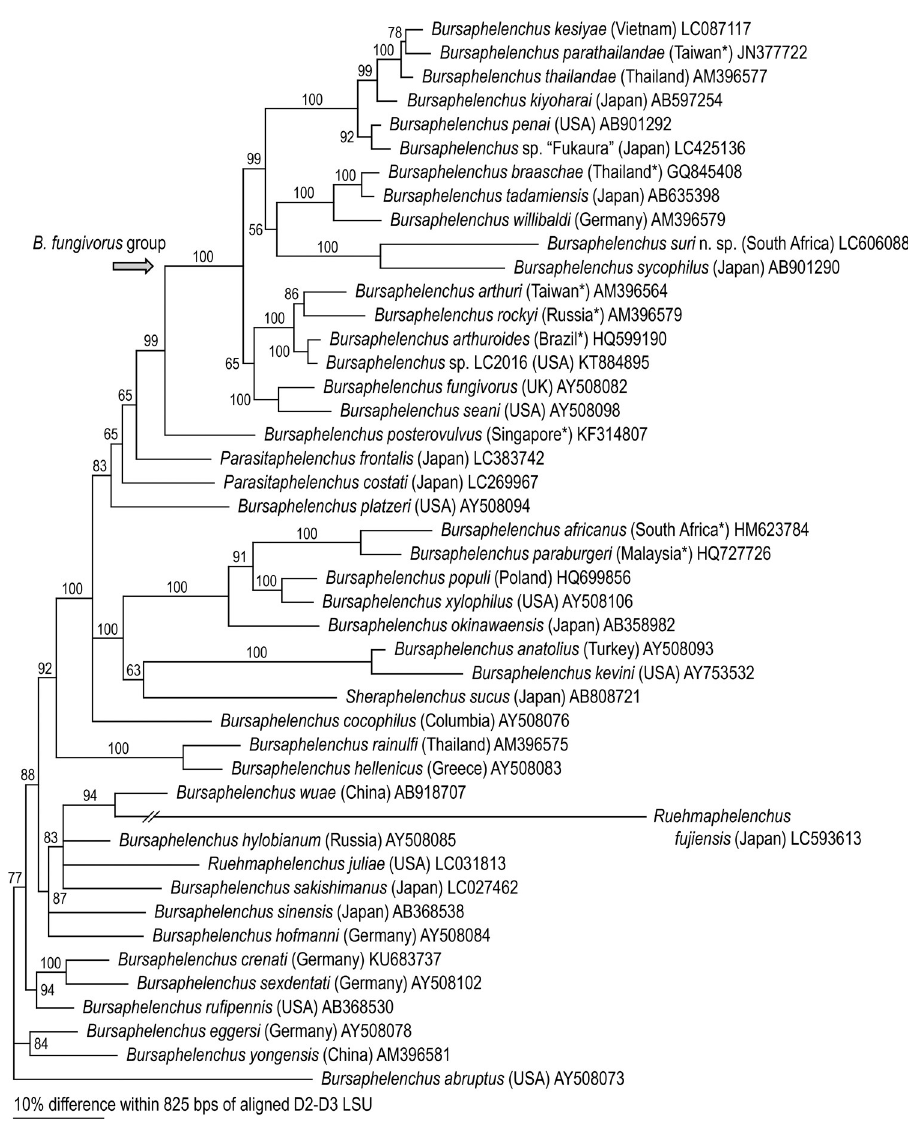
Fig 2. Bayesian tree inferred from D2-D3 LSU under GTR+G+I model. For model selection, AIC = 24371.263; lnL = -12088.342. Analytical parameters are: freqA = 0.21, freqC = 0.19, freqG = 0.32, freqT = 0.28; R(a) = 0.17, R(b) = 1.68, R(c) = 0.53, R(d) = 0.34, R(e) = 3.05, R(f) = 1.00; Pinva = 0.32; Shape = 0.88. Posterior probability values exceeding 50% are given on appropriate clades. The type locality of each species marked with an asterisk suggests that the material was isolated from wooden packing material imported from that